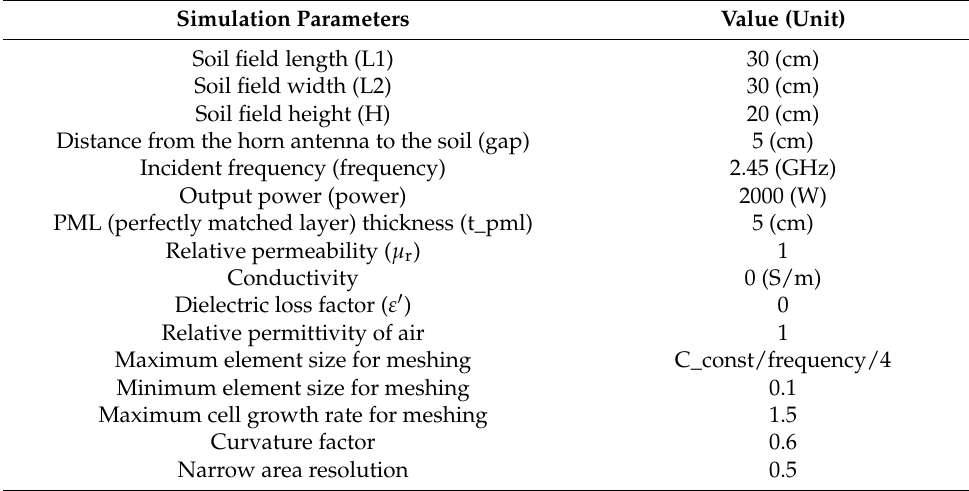
Table 1. Specific parameter settings in the simulation process.